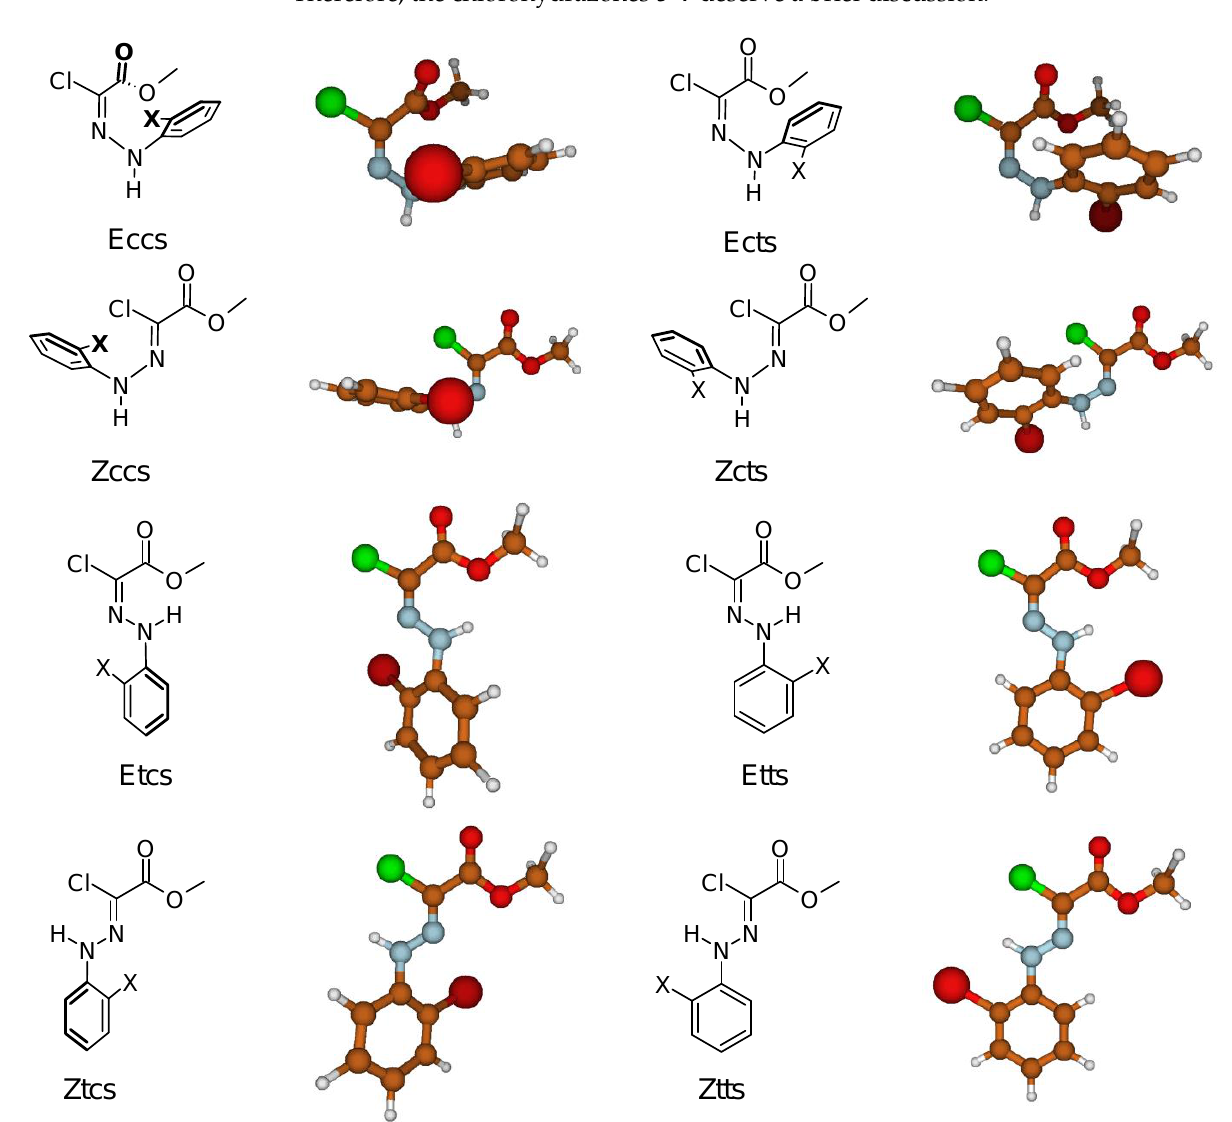
Figure 12. Selected ( γ = s) ω B97M-D4/cc-pVTZ minimum energy structures of 7 (X = I). They are representative of the corresponding γ = a isomers and of the structures of 5 and 6 .